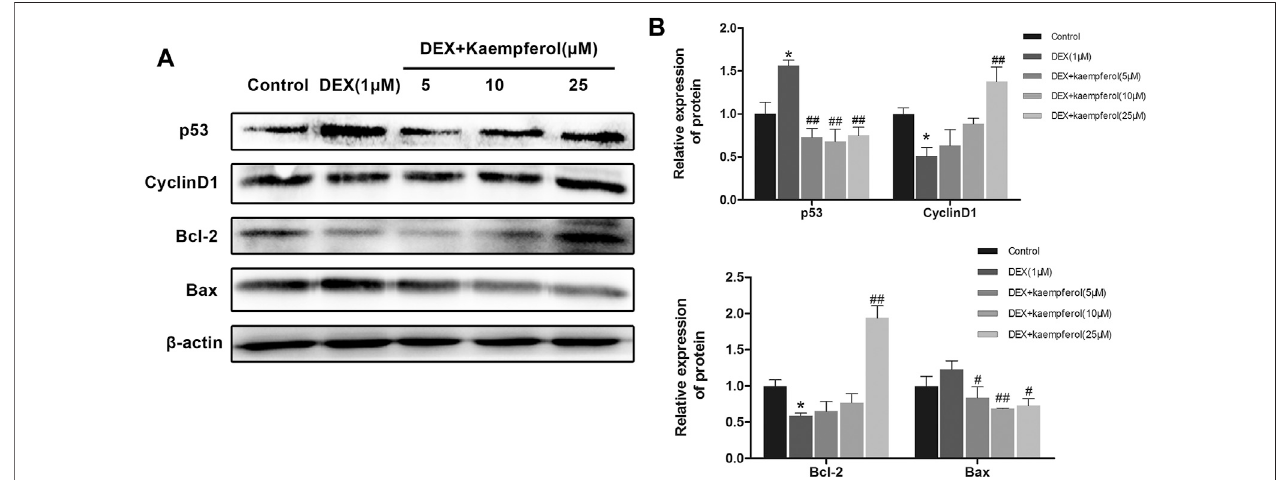
FIGURE 4 | Kaempferol attenuated DEX-induced decrease of cyclin D1 and Bcl-2 expression and augment of p53 and Bax expression. (A) The proteins were detectedwithspeci fi cantibodies against p53, cyclinD1, Bcl-2, and Bax. β -actin wasusedasthe loadingcontrol. (B) Thequanti fi cation ofp53, cyclinD1, Bcl-2and Bax was indicated. * p < 0.05 vs. Control; # p < 0.05, ## p < 0.01 vs. DEX.